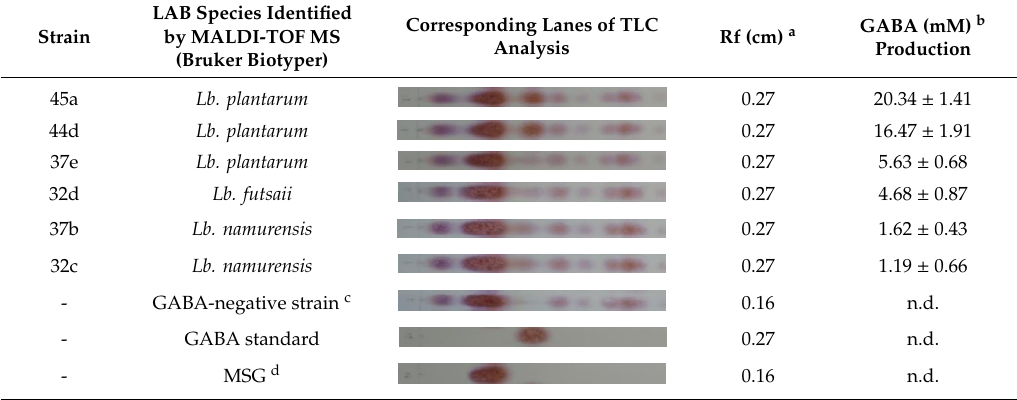
Table 3. LAB with GABA-producing abilities after 48 h cultivation.